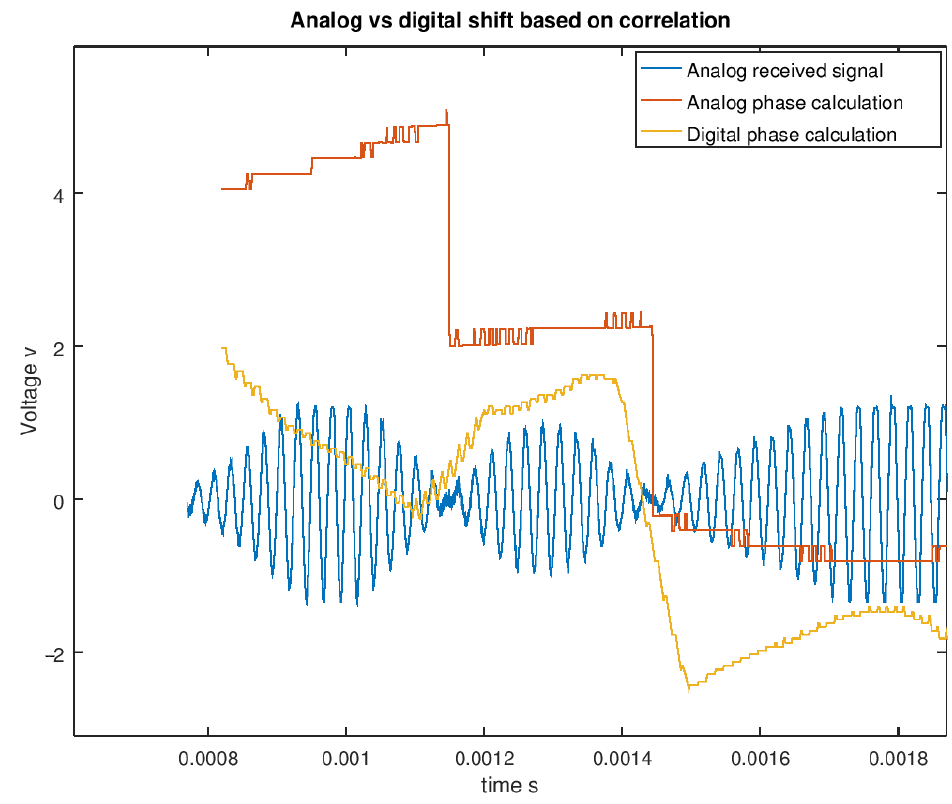
Figure 14. Signal demodulation and code